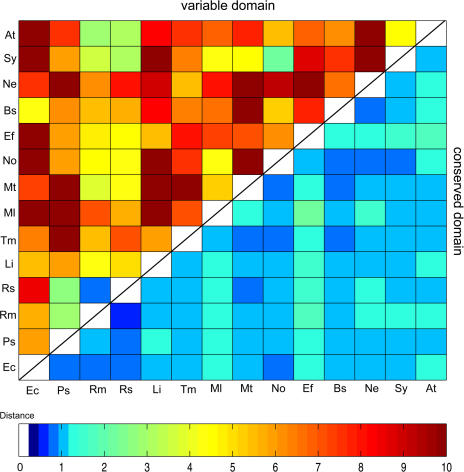
2D Representation of the Distance Matrix Computed from the Variable and Conserved Domains in a Group of Similar HKsThe upper triangle shows the variable domains, the lower one the conserved domains. Amino acid sequence distances are calculated by the PROTDIST program using the Dayhoff PAM matrix. The sequence from each species is the best match (E-value < 1E-10) in that genome to the query E. coli gene. Abbreviations for organisms: Ec, Escherichia coli K12; Ps, Pseudomonas syringae pv. syringae B728a; Rm, Ralstonia metallidurans; Rs, Ralstonia solanacearum; Li, Listeria innocua; Tm, Thermotoga maritime; Ml, Mycobacterium leprae; Mt, Mycobacterium tuberculosis CDC1551; No, Nostoc sp. PCC 7120; Ef, Enterococcus faecalis; Bs, Bacillus subtilis; Ne, Nitrosomonas europaea; Sy, Synechococcus sp. PCC 7942; At, Agrobacterium tumefaciens. The PROTDIST program is included in the PHYLIP software package version 3.5 (Felsenstein 1989).